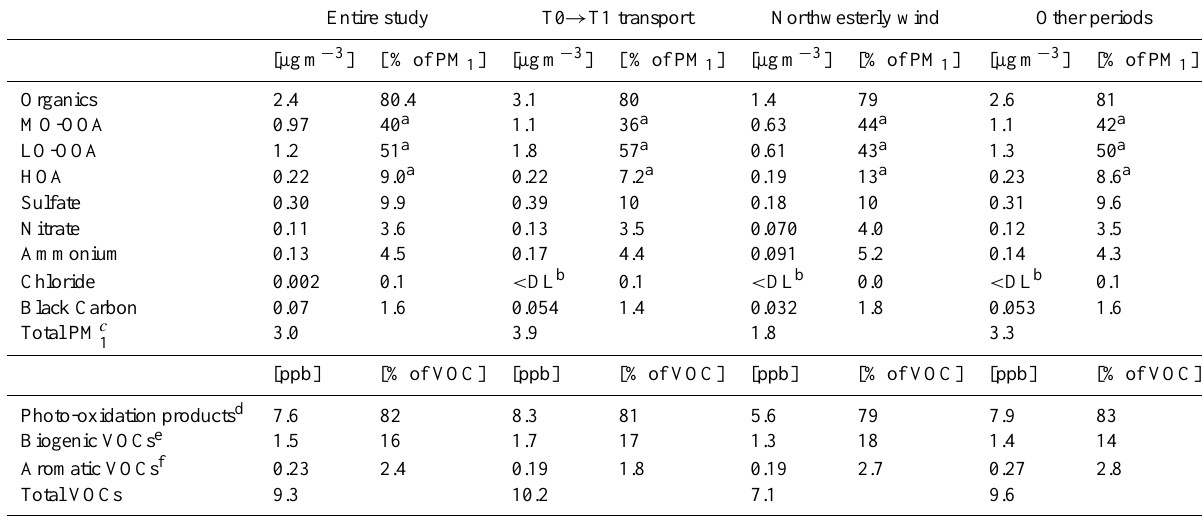
Table 1. Summary of the average concentrations and % of total PM 1 or VOCs during the entire study and in the three air masses as marked on Fig. 2.